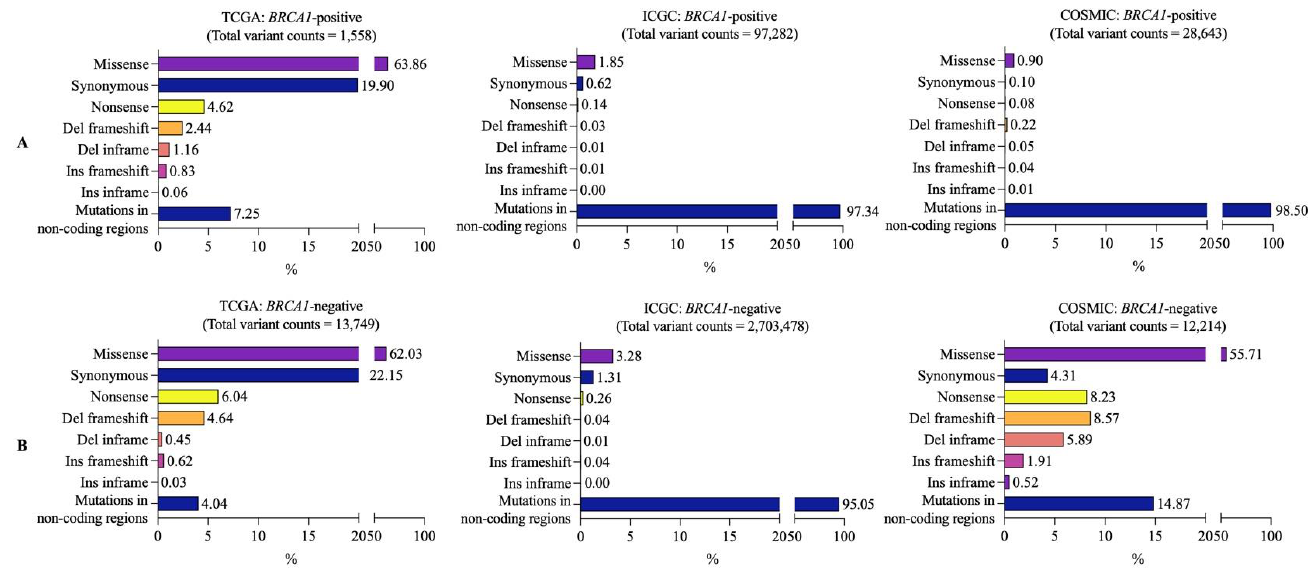
Figure 3. Coding-region variant classification in ( A ) BRCA1 -positive and ( B ) BRCA1 -negative breast cancer samples. Numbers on the bar graphs indicate the percentage of coding-region variant types per total variant count. (Del frameshift = frameshift deletion, Del inframe = inframe deletion, Ins frameshift = frameshift insertion, Ins inframe = inframe insertion).